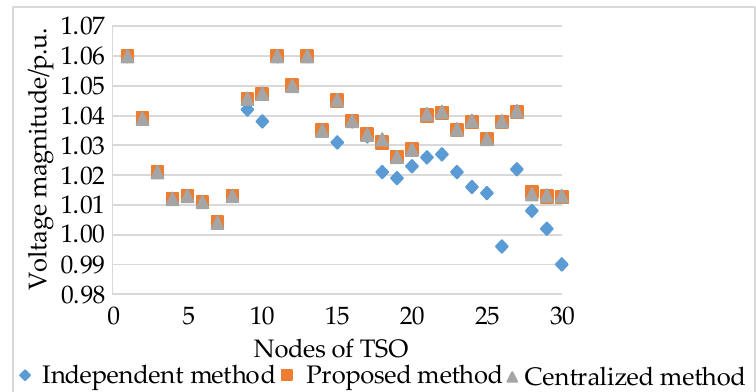
Figure 4. Voltage distribution of TSO with different methods on test case 1.